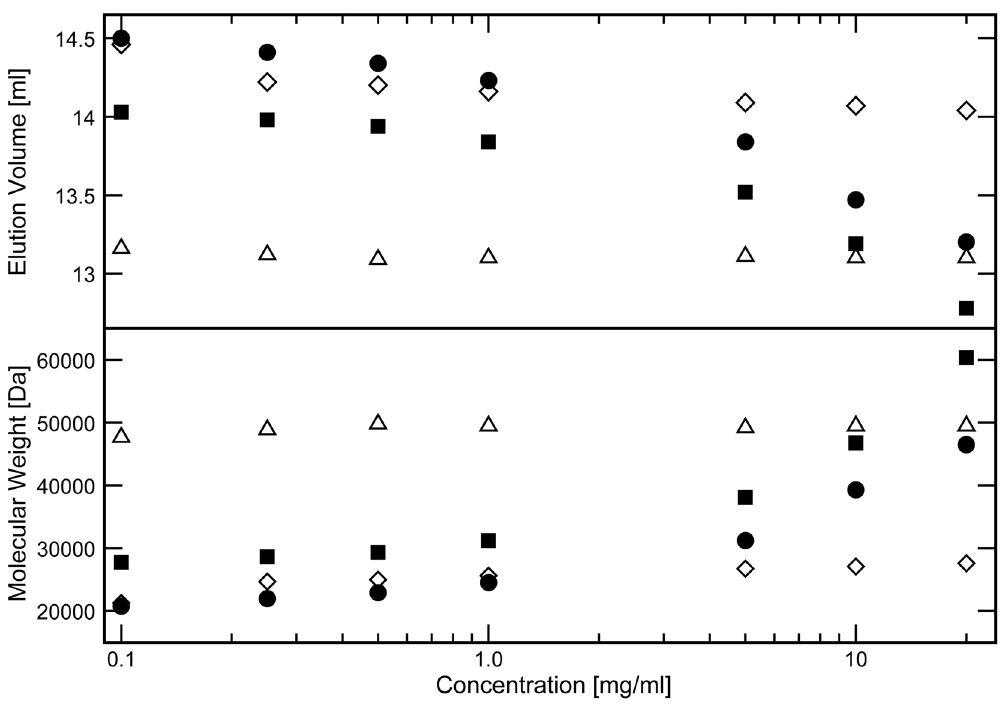
Figure 2. The DAPk-DD shows concentration dependent oligomerization. (A) Control proteins GB1-FADD-DD (open diamonds) and ovalbumin (open triangles) along with GB1-DAPk-DD(S) (filled circles) and GB1-DAPk-DD(L) (filled squares) constructs were run at seven different concentrations through a Superpose-12 analytical gel filtration column and the elution volumes were plotted. (B) The elution volumes shown in (A) were converted into apparent MWs using the calibration curve (Figure S3). Two sets of data were collected for each sample and the average value shown. Elution volume differences between sets were # 0.04 ml.